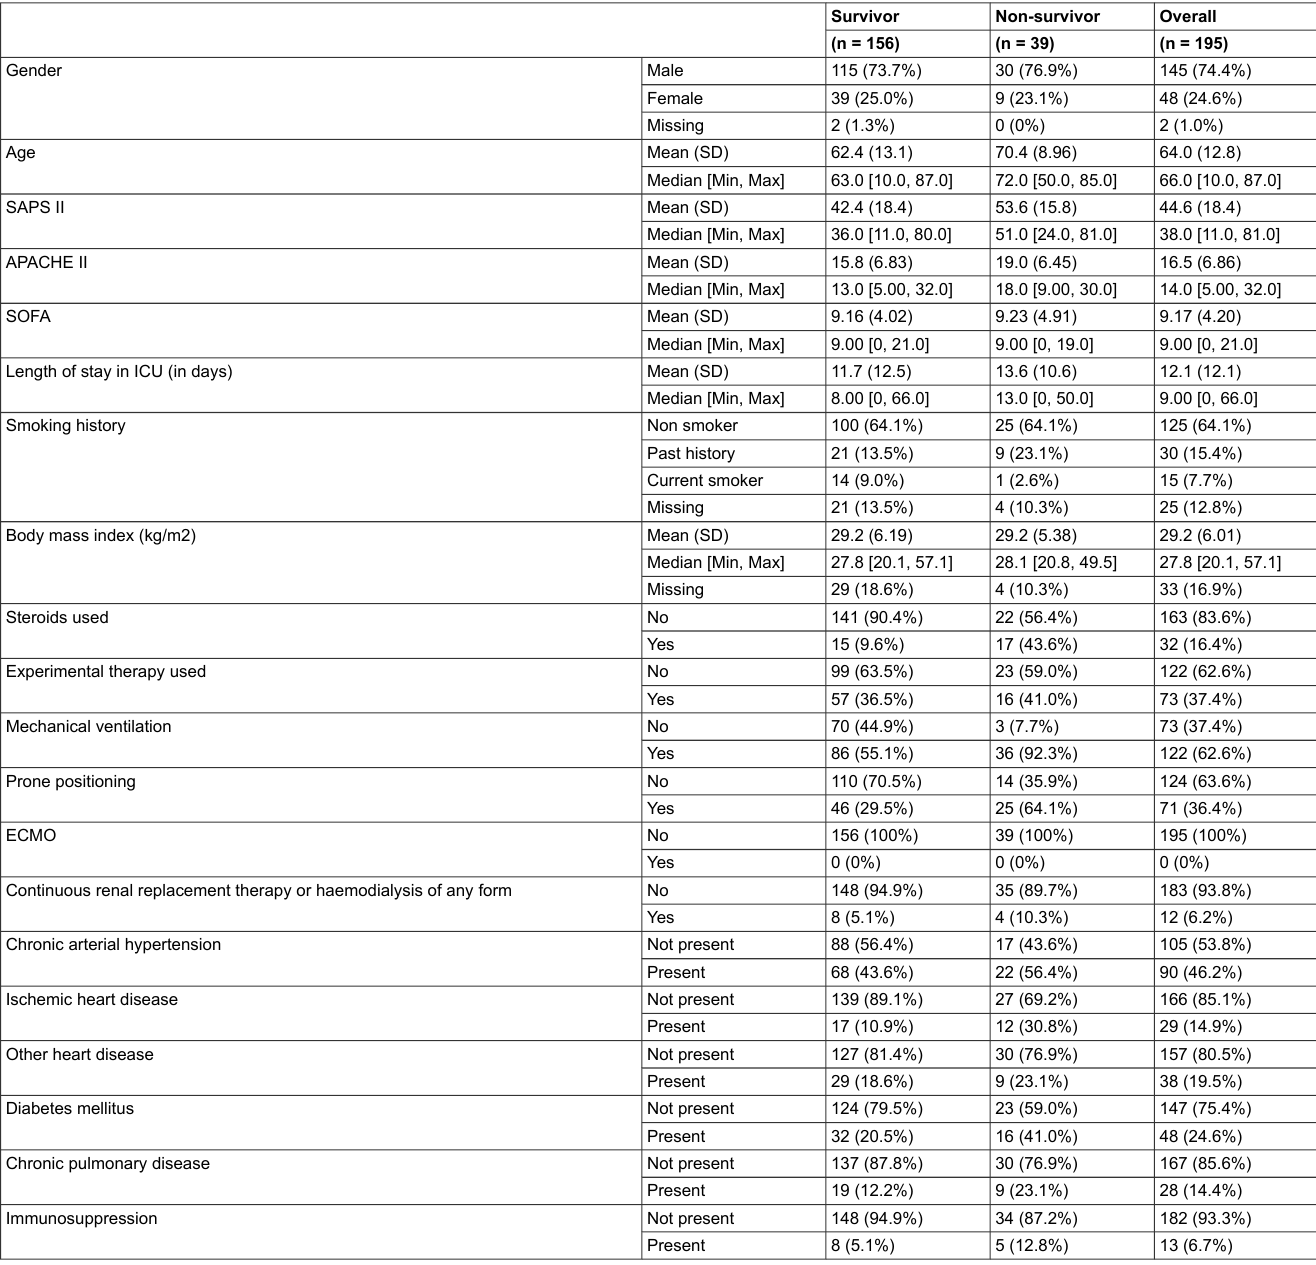
Table S2: Characteristics of patients with known discharge status from 19 hospitals not recording critical care